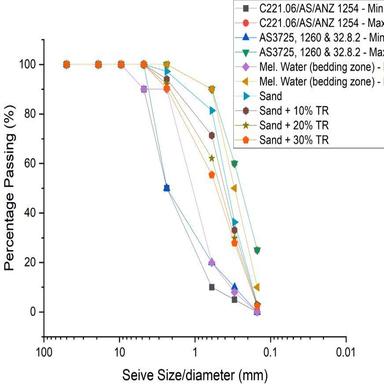
Comparison of PSD curve of the sand and sand-tyre mixes investigated with different Australian standards and guidelines.